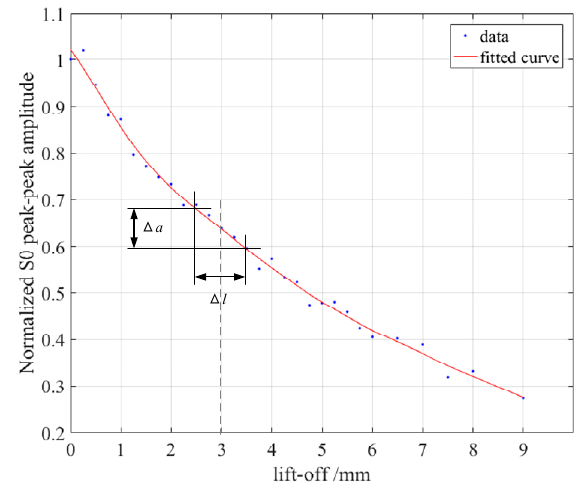
Figure 13. The lift-off of the receiving coil versus the amplitude of the S0 Lamb wave.